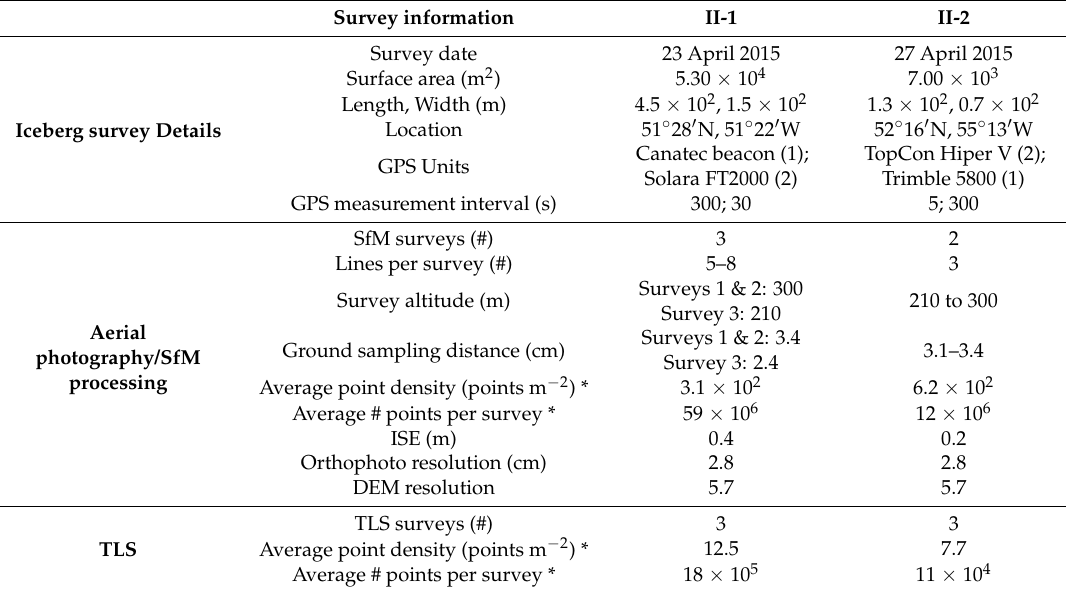
Table 3. General and technique-specific details pertaining to the surveys of i1 and i2. Values in parentheses represent a range. SfM = structure-from-motion photogrammetry, TLS = terrestrial laser scanning, DEM = digital elevation model, ISE = Inter-survey